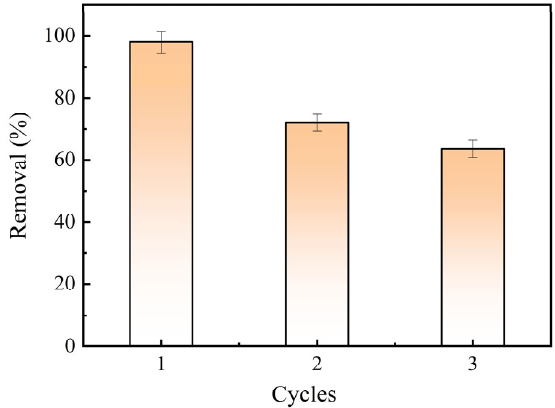
Figure 11. Reusability of the